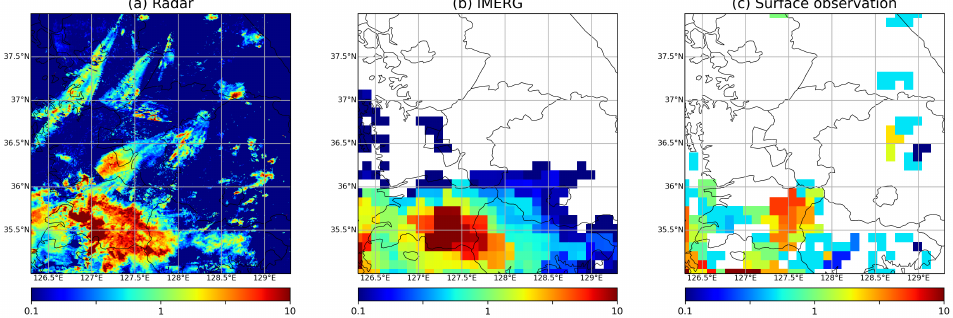
Figure 9. The reference rain maps on 01 UTC 27 July 2019 of radar, IMERG, and surface observations from RAIN-F+